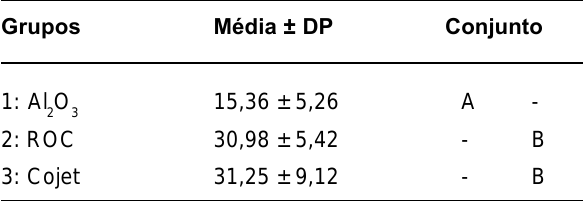
TABELA 1 - Média e desvios padrões dos valores